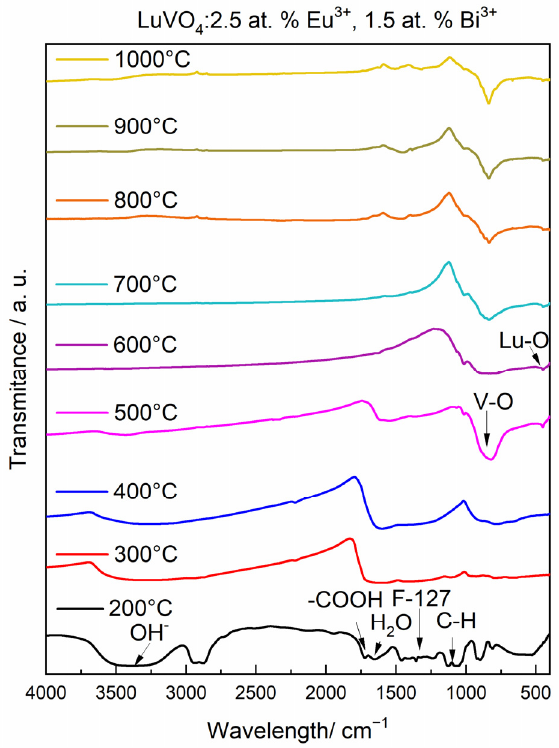
Figure 1. FTIR spectra of LuVO 4 : 2.5% at. Eu 3+ , 1.5% at. Bi 3+ chemical evolution.